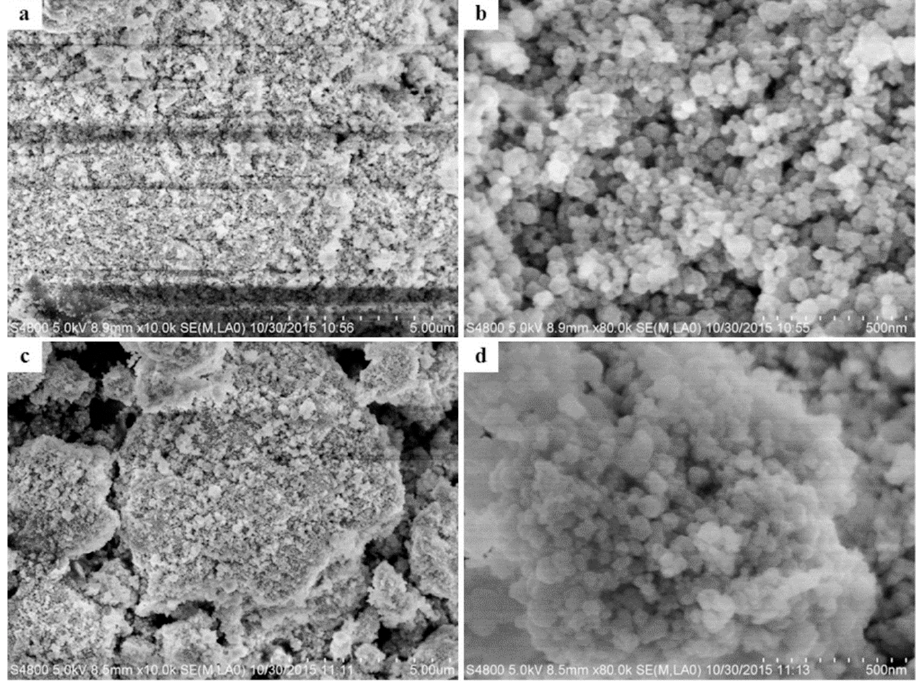
Figure 12. SEM images of the catalysts: ( a ) Mn-Ce/TiO 2 10,000 multiplier; ( b ) Mn-Ce/TiO 2 80,000 multiplier; ( c ) Pb (0.5)-Mn-Ce/TiO 2 10,000 multiplier; ( d ) Pb (0.5)-Mn-Ce/TiO 2 80,000 multi- plier